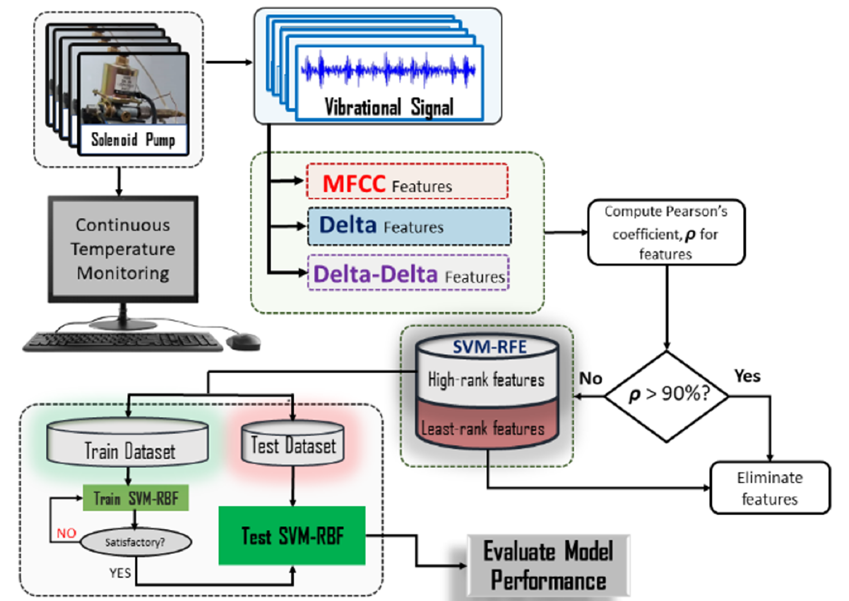
Figure 2. Proposed fault detection and isolation (FDI)